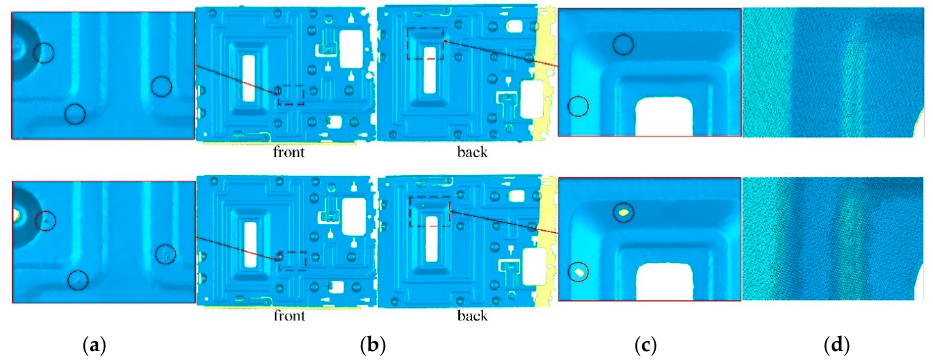
Figure 16. Comparison of our scan results ( top row ) with the Creaform scanner [7] ( bottom row ); ( a ) a comparison of zoomed details at the same location; ( b ) the front and back views; ( c ) the details of another region; ( d ) triangles of the mesh models.